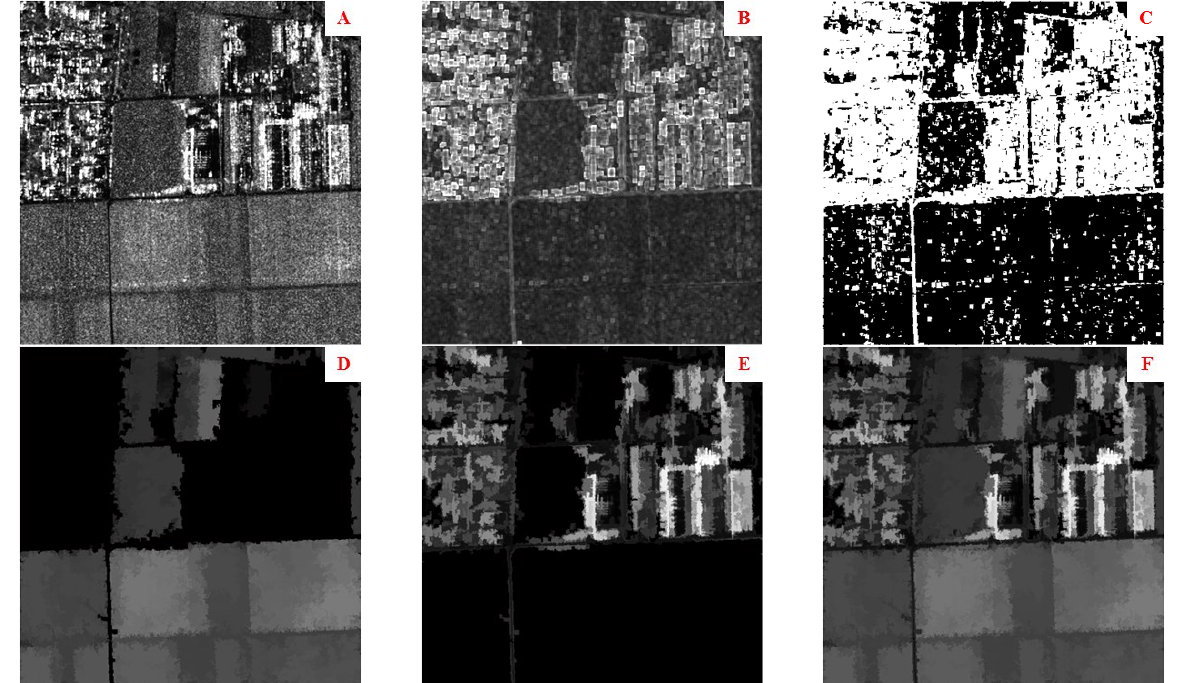
Figure 1: Adaptive ASF denoising: input ML mean subset image (A); Cov 5 x 5 of input image (B); detected heterogeneous (white) and homogeneous (black) regions (C); denoised homogeneous regions (D), denoised heterogeneous regions (E) and combined result